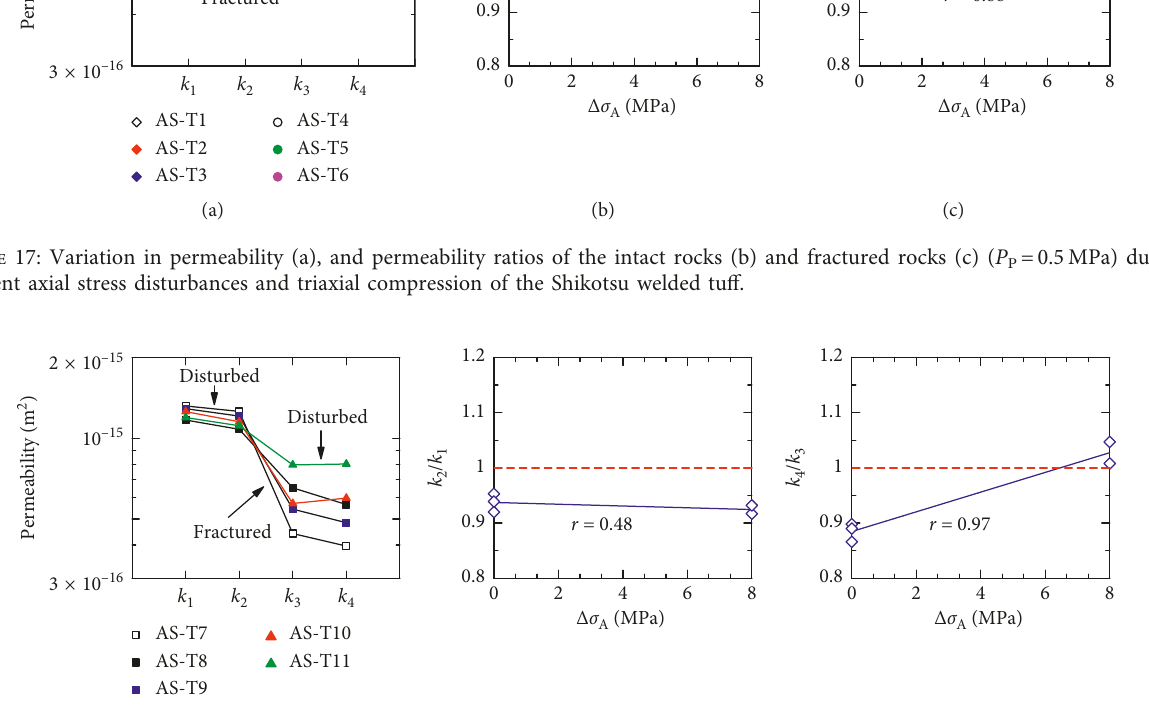
P (cid:31) 0.1 MPa) due to